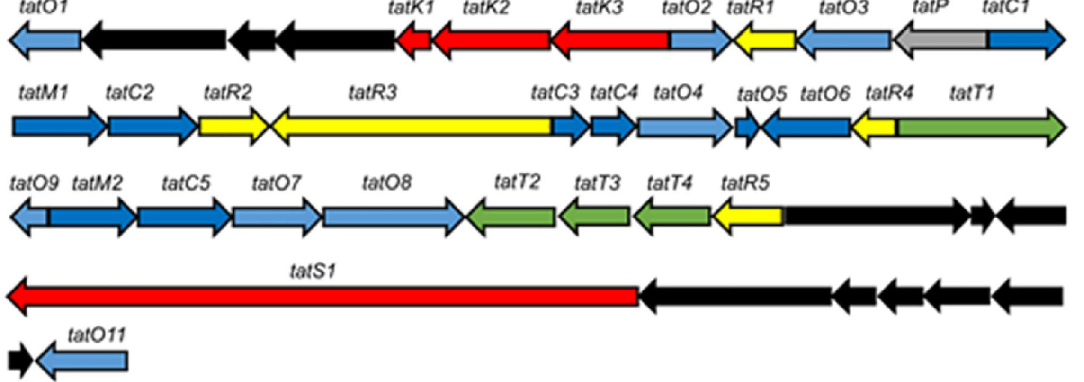
Figure 2. Organization of the tatiomicin BGC. Genes coding for polyketide biosynthesis (red; tatS = starter unit biosynthesis, tatK = chain biosynthesis), polyketide modification (blue; tatO = oxidoreductases, tatC = cyclases, tatM = methyltransferases), regulation (yellow; tatR), transport (green, tatT) and others (grey; tatP = phosphorylase, black; genes not assigned to the tatiomicin BGC based on homology to the rishirilide BGC and proposed biosynthetic